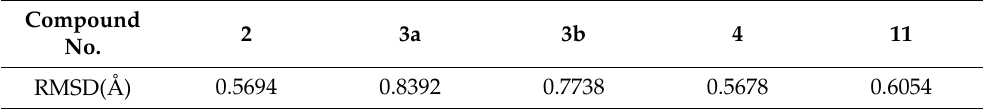
Table 5. RMSD values of hit compounds.